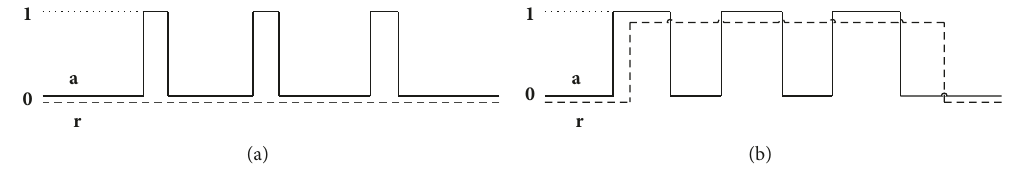
Figure 4: Strong synchronization requirement.